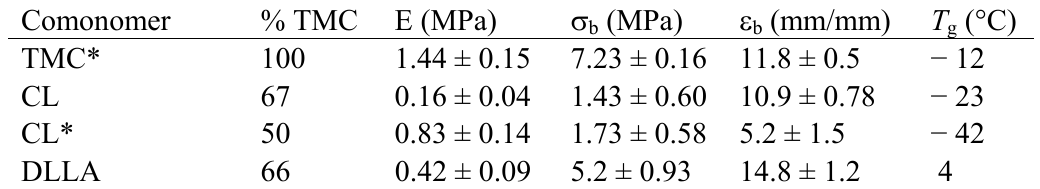
Table 2 . Mechanical properties measured in uniaxial tension of elastomers prepared from TMC-containing copolymer